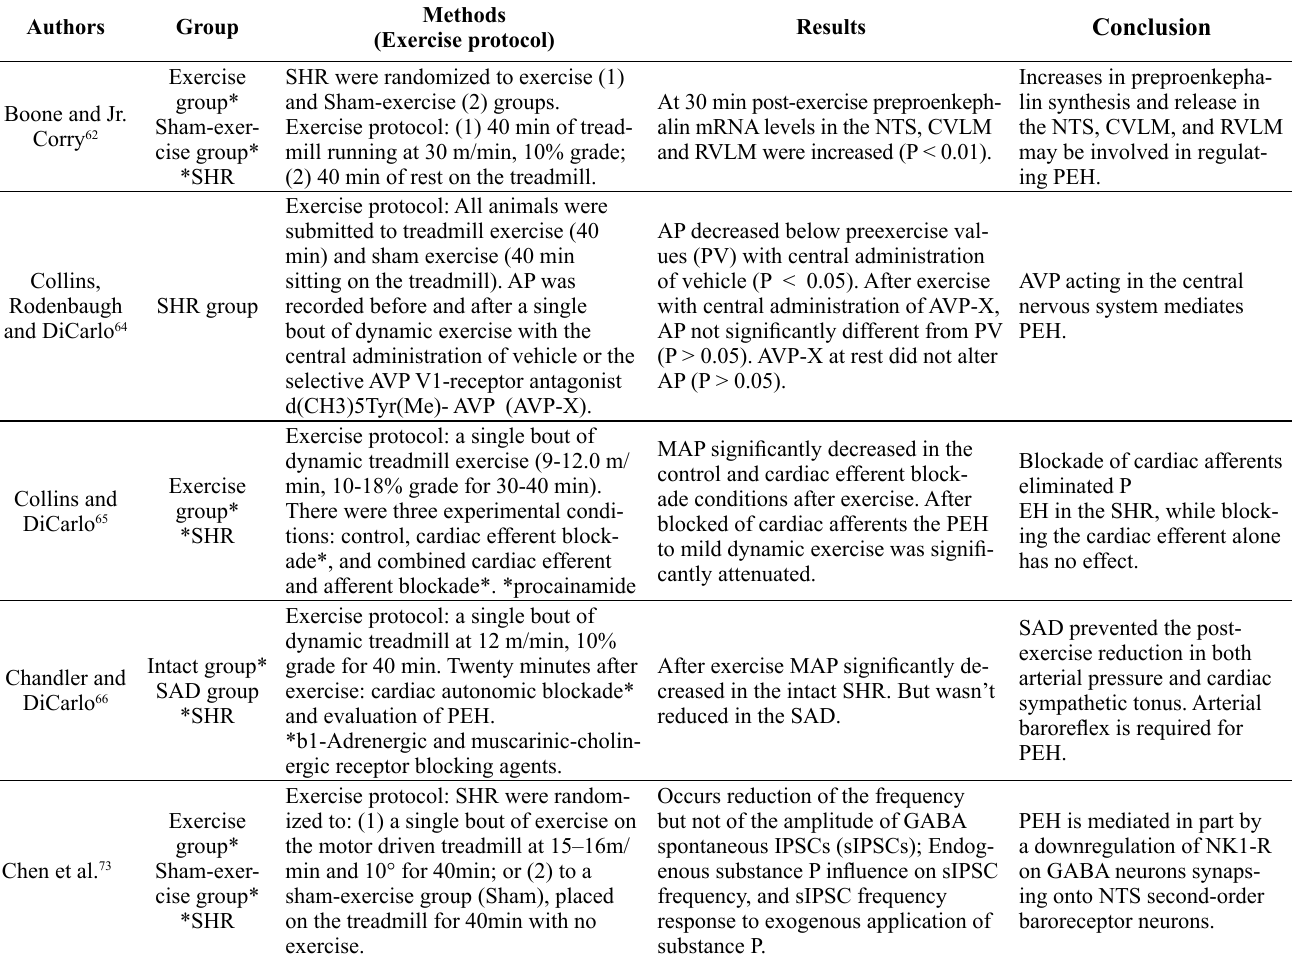
Table 2. Experimental studies and neural mechanisms associated with PEH. Methods Authors Group (Exercise protocol)